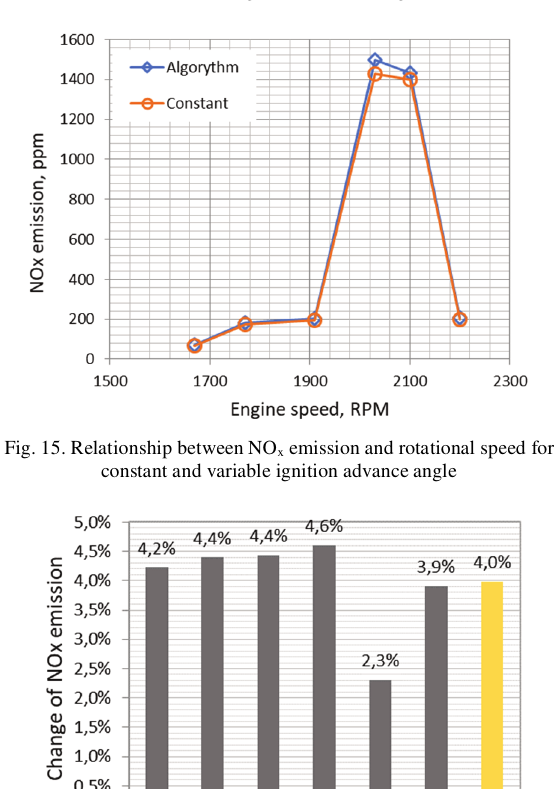
Fig. 14. Differences in CO 2 emission power between engines with constant and variable ignition advance angle